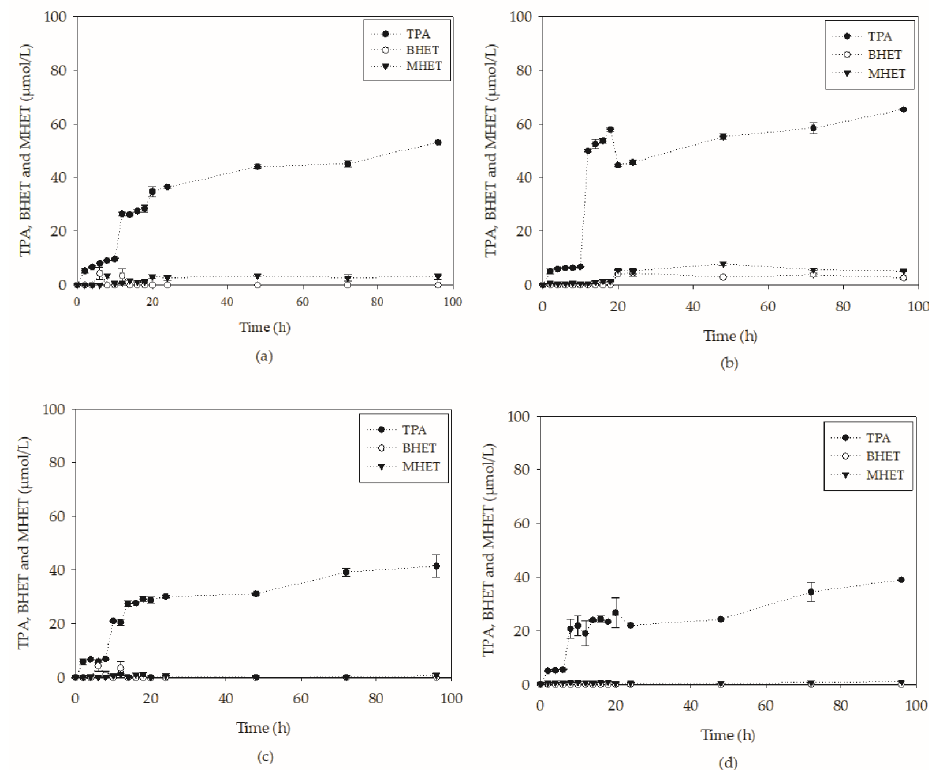
Figure 7. Hydrolysis products of PC-PET obtained during submerged cultivation of Y. lipolytica IMUFRJ 50682 in ( a ) YP, ( b ) YT, ( c ) YPD and ( d ) YTD medium at 28 ◦ C and 250 rpm for 96 h.